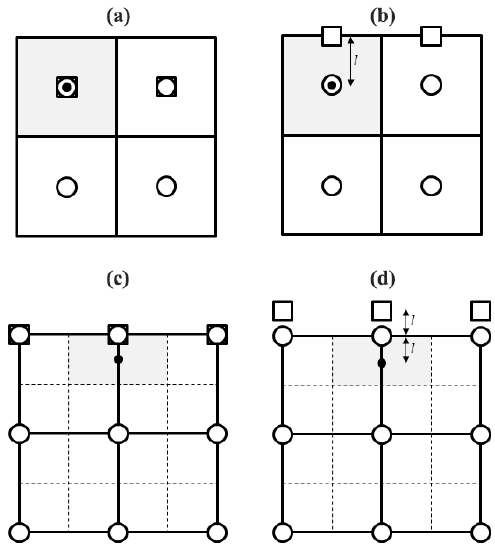
Figure 1. (a) Common nodes in cell-centered schemes. (b) Dual nodes in cell-centered schemes. (c) Common nodes and colocated dual nodes in vertex-centered schemes. (d) Dual nodes in vertex- centered schemes (not colocated). The white squares and white cir- cles represent surface and subsurface nodes, respectively. The solid and dashed lines represent the primary mesh and the dual mesh, respectively. The grey-shaded area is a topmost discrete volume as- sociated with a topmost subsurface node. The black dot represents the centroid of this volume. The coupling length l as depicted in this figure applies to the consistent dual node